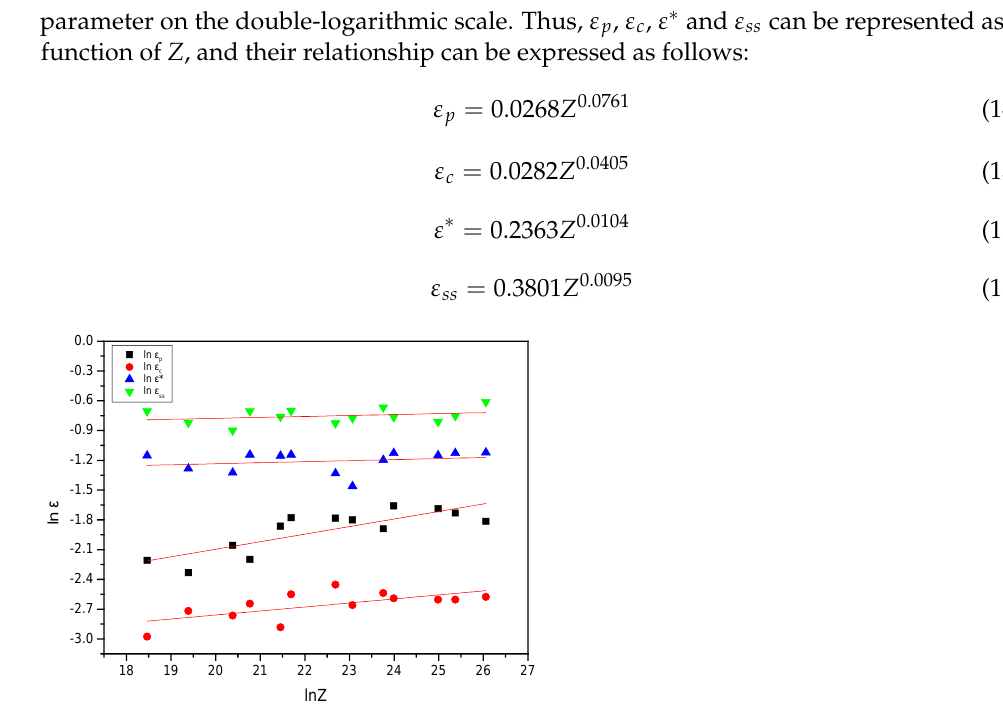
∗ and ε p , ε c , ε ss on parameter Z